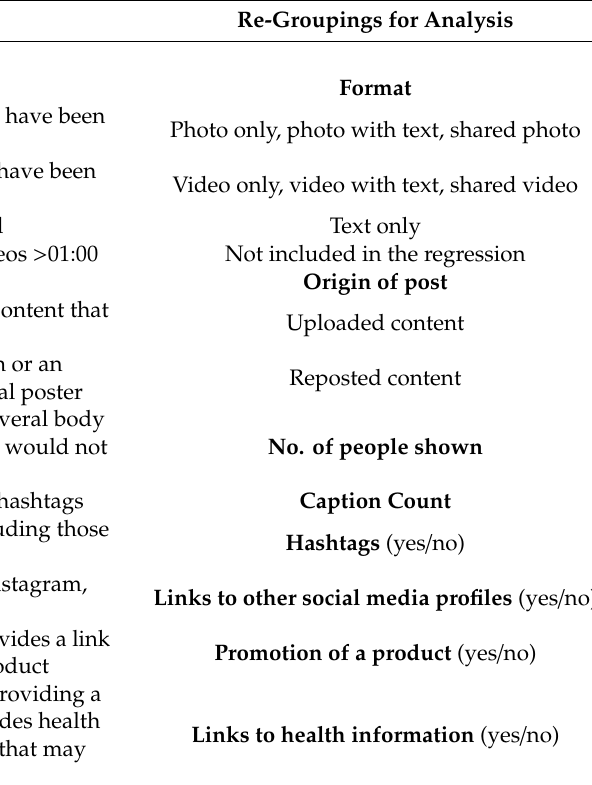
Table A1. Coding framework used during data collection; definitions are adapted from those previously published by Klassen et al.